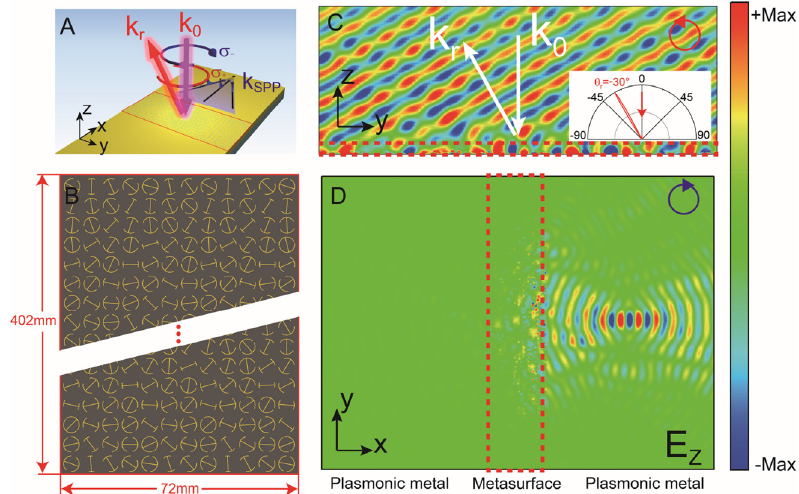
Figure5: Abi-functionalmetasurfaceforboth PW and SW